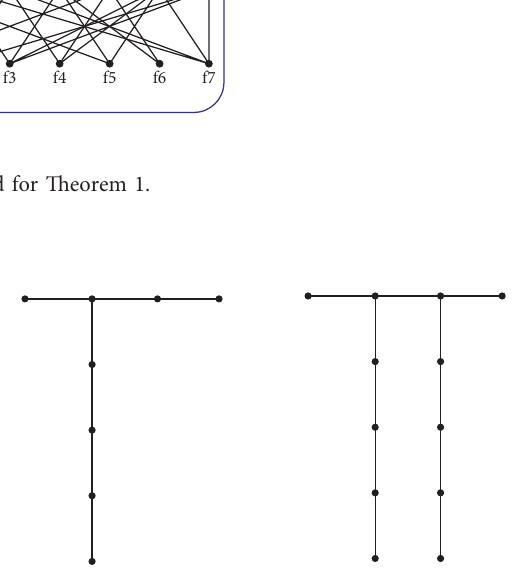
, H obtained from T 1 2